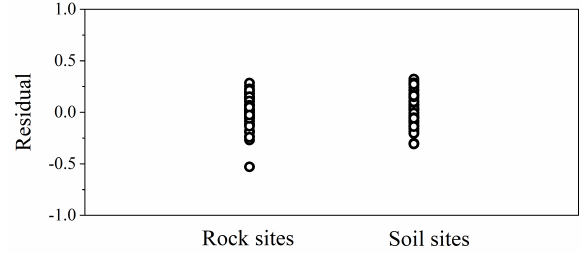
Fig. 8. Distribution of residuals between the actual and predicted log 10 D s 5 − 95% for the proposed ANN model with respect to site conditions.